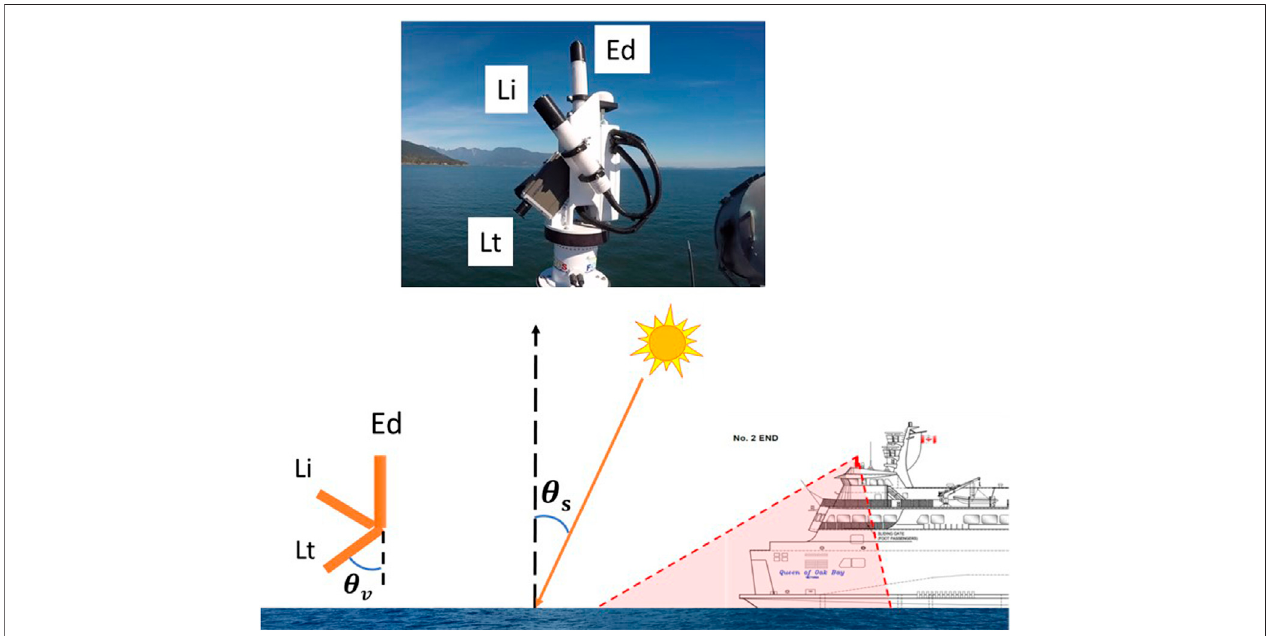
FIGURE2| TheautonomousradiometerSAS-SolarTrackerisinstalledonthedeckoftheferry,QueenofAlberni.Downwellingirradiance(E d ),skyradiance(L i )and total radiance (L t ) radiometric sensors are shown. θ v = 50 ° is the sensor viewing zenith angle and θ s = 30 ° is the low sun elevation angle (data acquisition occurs only above θ s